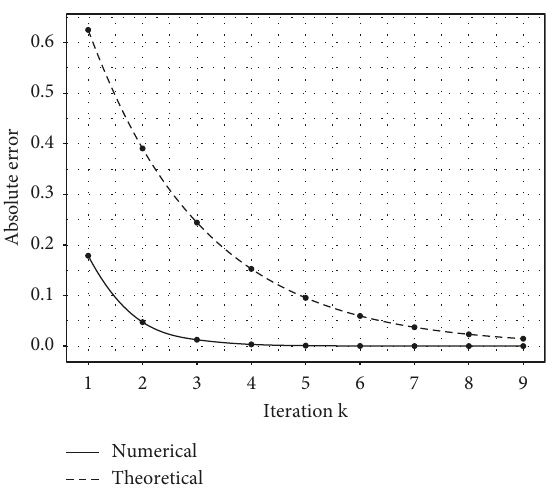
Figure 5: Absolute error (numerical) and Q k versus iteration k .